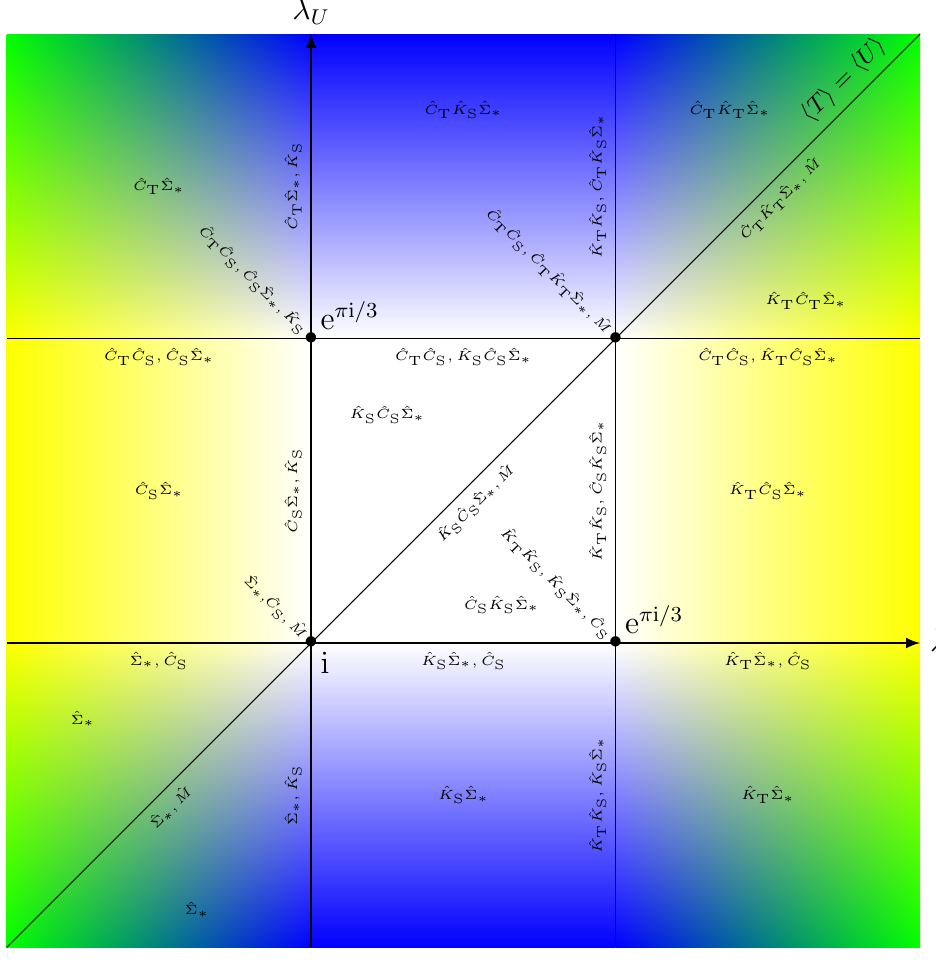
Figure 7 . Generators of the stabilizers H for h T i ∈ λ T and h U i ∈ λ U . The axes λ T and λ U ( h T i , h U i ) correspond to the curves on the boundaries of the two-dimensional fundamental domains of T and U , see e.g. figure 6 for λ T . The diagonal depicts the hypersurface where h U i = h T i on the curves λ T and λ U . The stabilizers above and below the diagonal are related by mirror symmetry ˆ M